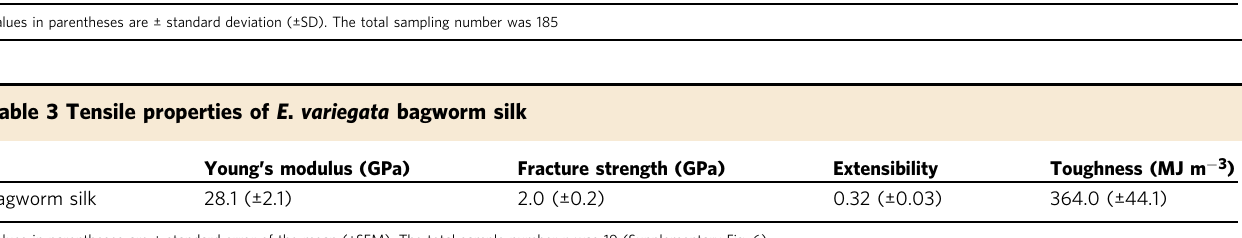
Bagworm silk (Last